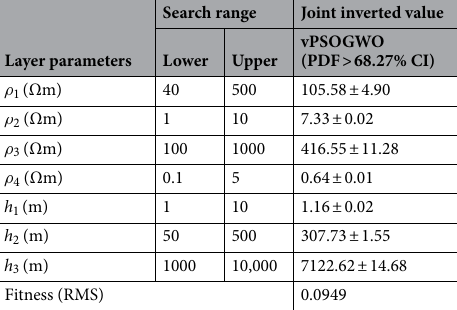
Table 11. Mean model with the level of uncertainty in the posterior utilizing vPSOGWO joint inversion of DC and MT data near Broken Hill in South Central Australia.